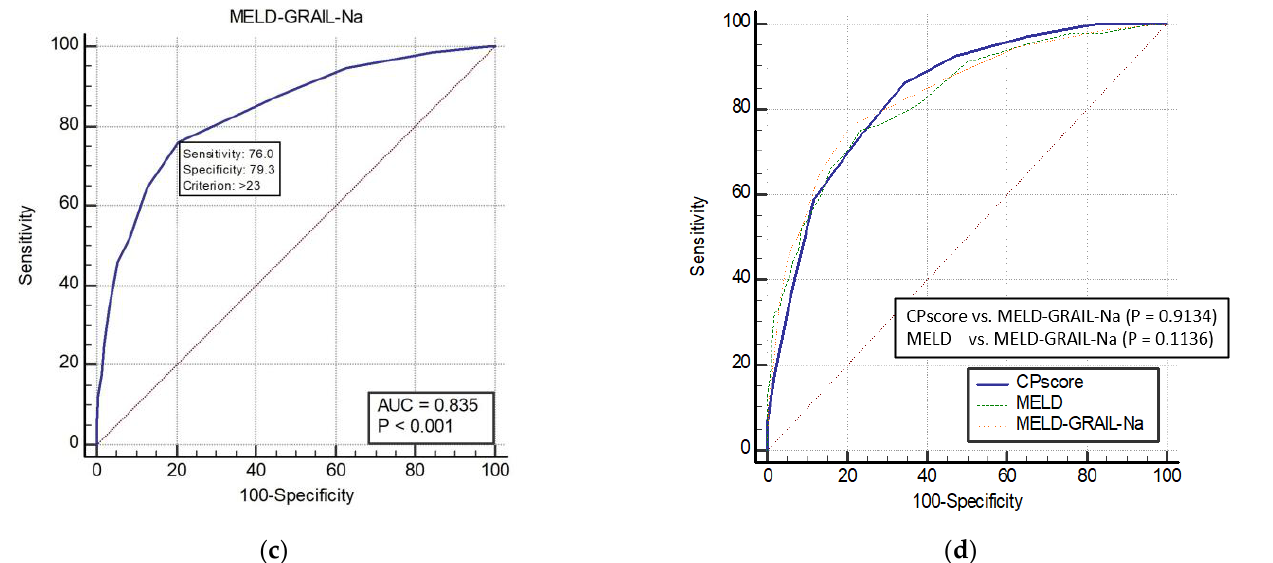
Figure 2. Receiver operating characteristic curves (ROC) and area under the ROC (AUROC) of patients with total cirrhosis for 3-month mortality. ( a ) CP score for 3-month mortality, 0.837 (95% CI, 0.815–0.857); ( b ) MELD for 3-month mortality, 0.827 (95% CI, 0.805–0.848); ( c ) MELD-GRAIL-Na for 3-month mortality, 0.835 (95% CI, 0.814–0.856); ( d ) comparison of AUROC for 3-month mortality between the CP, MELD, and MELD-GRAIL-Na scores.